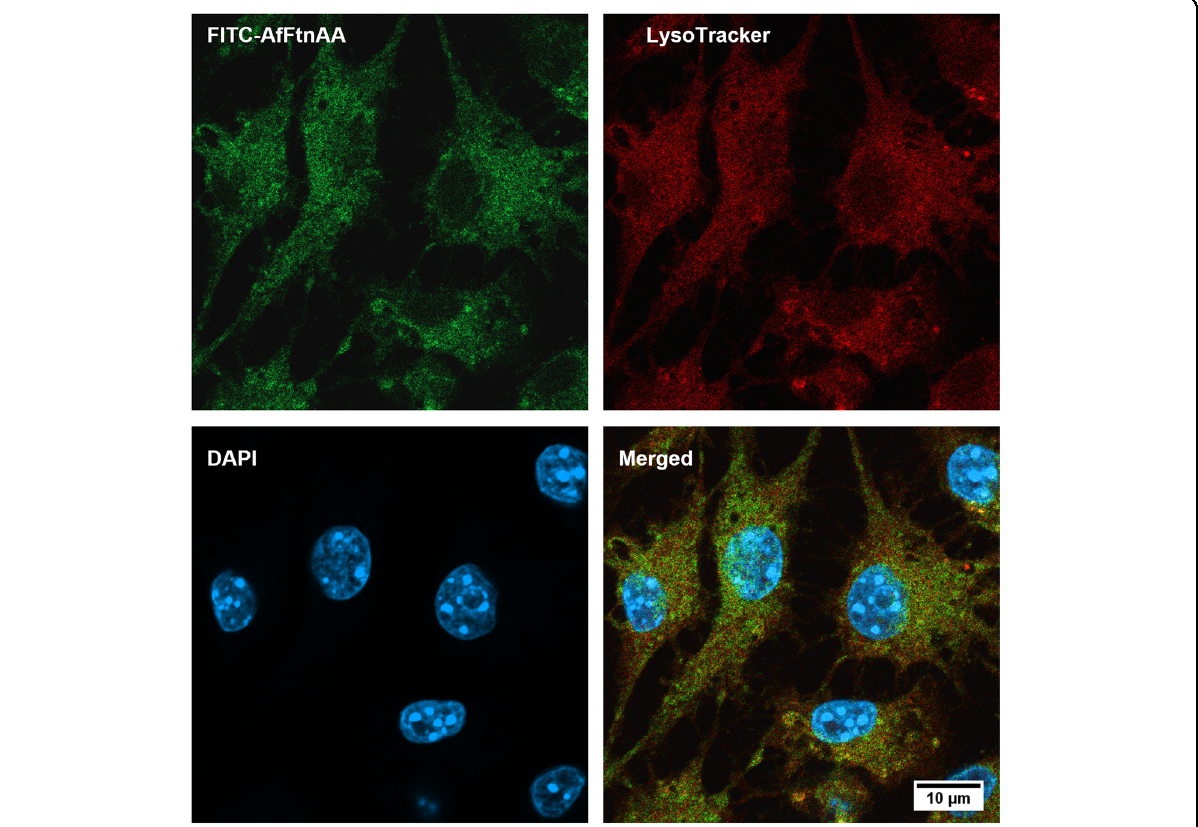
Fig. 1 Confocal imaging of 200 nM FITC (green)-conjugated AfFtnAA uptake by RAW264.7 cells after 24 h of incubation. Cells were stained with DAPI (blue) and LysoTracker (red) to visualize the nuclei and lysosomal compartments,